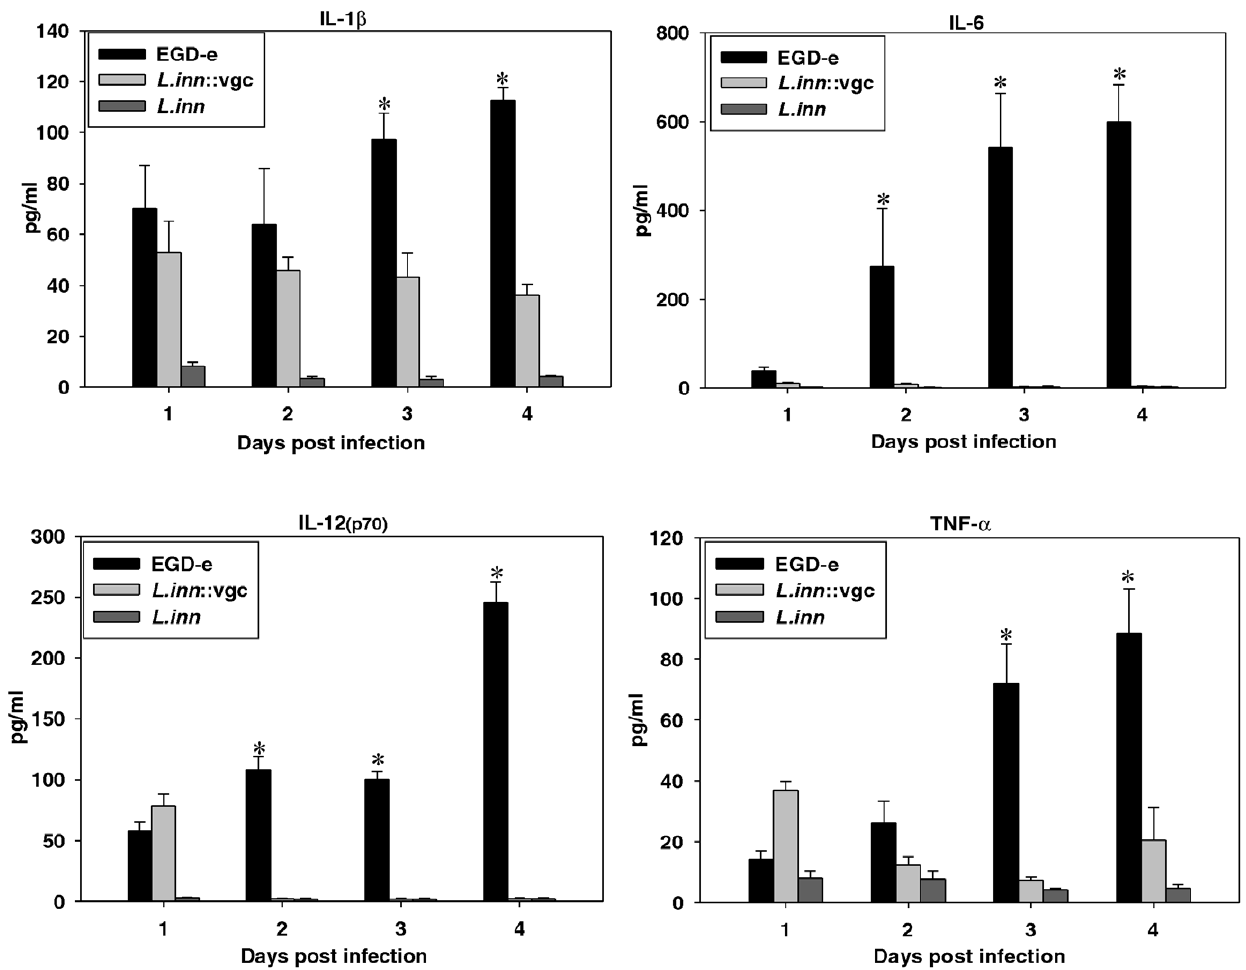
Figure 2. Measurement of proinflammatory cytokine levels in serum. Sera was obtained from mice on days 1, 2, 3, and 4 post-infection after inoculation with 10 3 cfu Lm , 10 7 cfu L.inn , or 10 7 cfu L.inn::vgc . Levels of IL-1ß, IL-6, IL-12(p70), and TNF-alpha were quantified using a multiplex cytokine assay kit. *P , 0.05 (EGD-e vs. L.inn and L.inn::vgc strains).